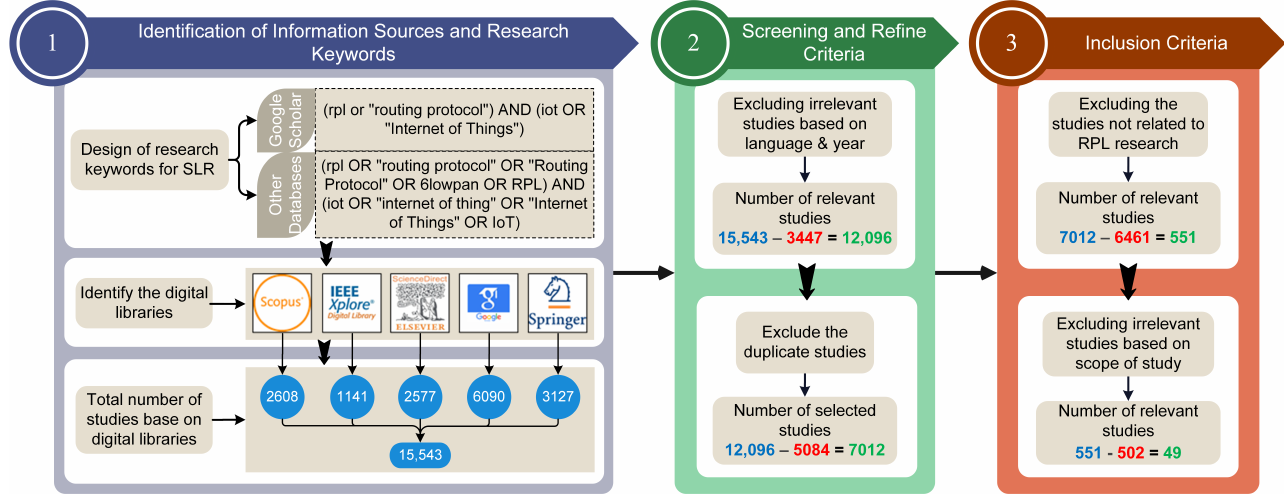
Figure 2. Flowchart of the SLR methodology